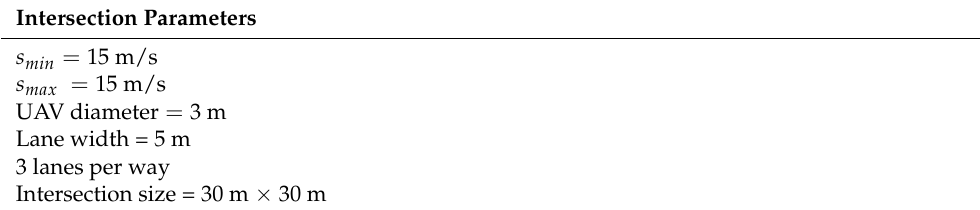
Table 4. Intersection parameters used in traffic light system and in our proposed system.